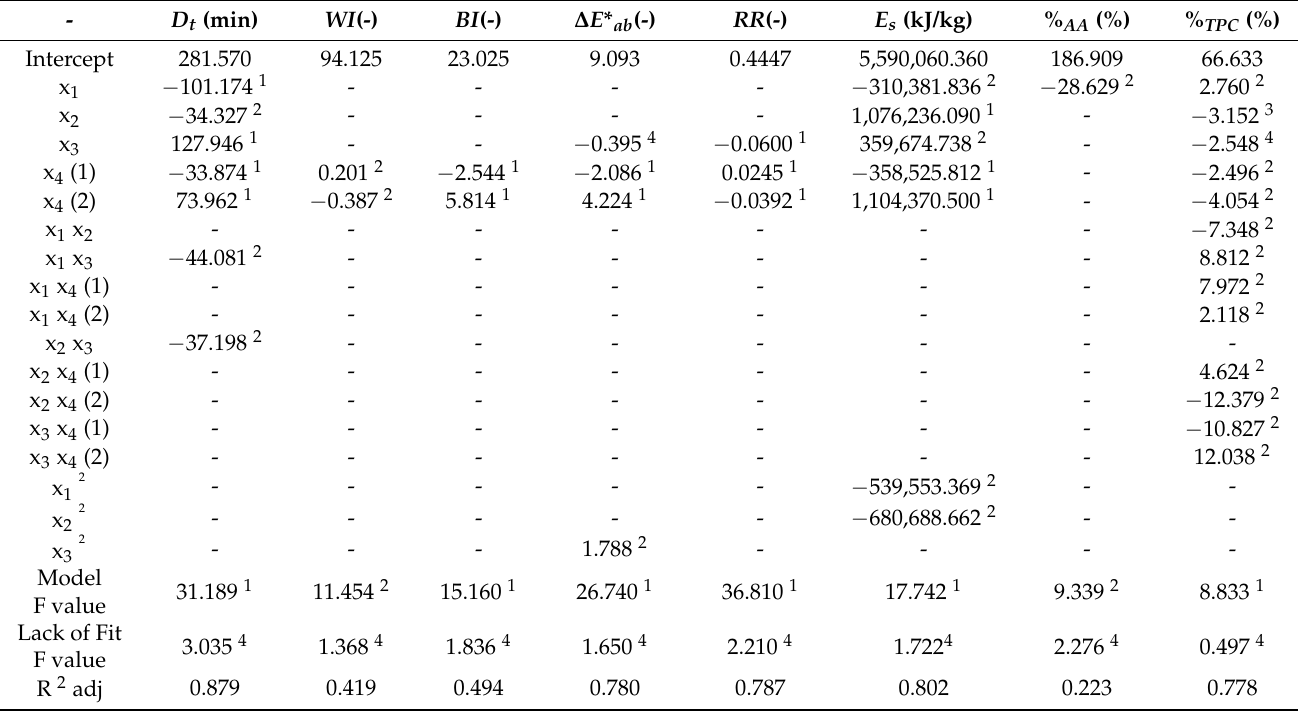
Table 3. Quality parameters and specific energy consumption of celeriac slices subjected to different drying temperatures, air velocities, sample thicknesses, and pre-drying